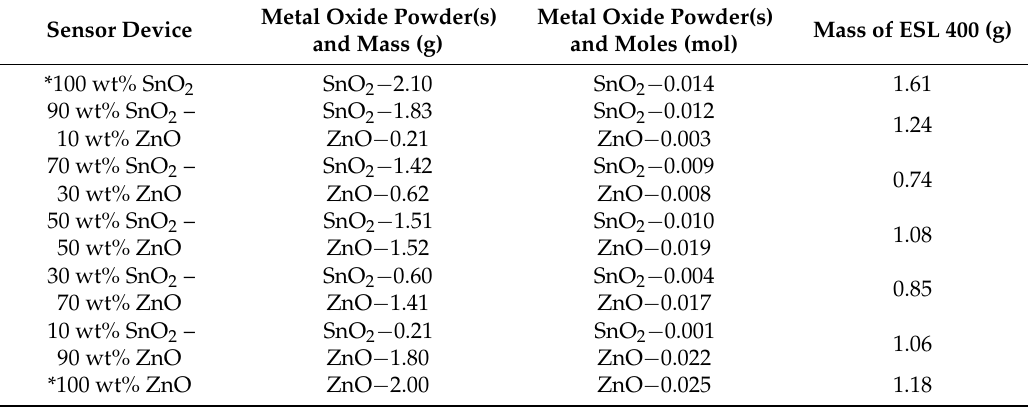
Table 1. MOS sensor devices fabricated for this work. Those sensor devices with an asterisk (*) are single-component metal oxide MOS sensor devices; all others are dual component metal oxide MOS sensor devices. Metal Oxide Powder(s) Metal Oxide Sensor Device and Mass (g)